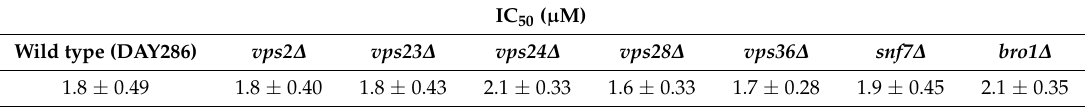
Table 1. Deletion of ESCRT pathway components does not affect activity of